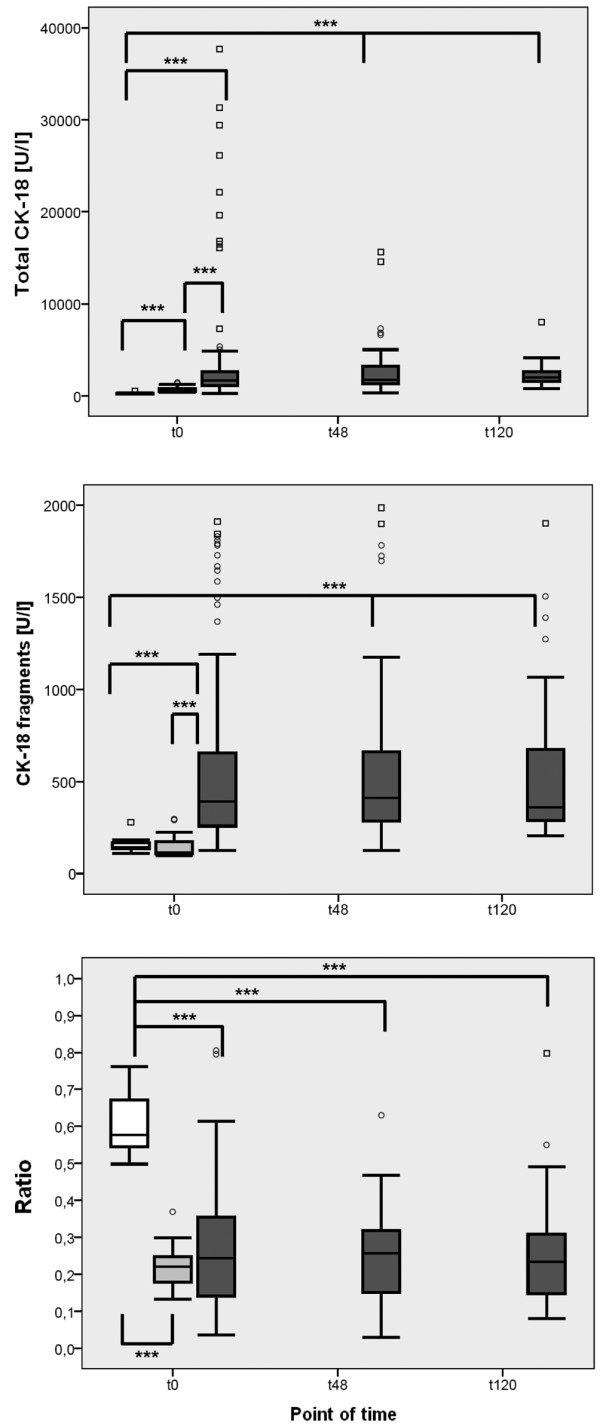
Comparison of cytokeratin measurements in the volunteer, postoperative, and septic groups at baseline and at 48 and 120 hours in the septic group. Concentrations were measured of total cytokeratin-18 (CK-18) and CK-18 fragments (CK-18-F), and the ratio of CK-18-F to total CK-18 was calculated from the sera of healthy volunteers ('Healthy', n = 18, white box), postoperative patients after major abdominal surgery ('Post-op', n = 28, light grey box), and patients with sepsis ('Sepsis', n = 101, dark grey box), at t0 (measured once for the volunteer group, immediately after surgery for the postoperative group, and at the time of diagnosis of sepsis for the sepsis group). In addition, for the septic group, the two other times of data collection are represented, t48 and t120 for 48 and 120 hours, respectively, after the diagnosis of sepsis. Data in box plots are given as median, 25th percentile, 75th percentile, and the 1.5 interquartile range. Outliers are shown in form of circles (1.5 to 3 interquartile ranges above 75th percentile or below 25th percentile) or rectangles (>3 interquartile ranges above 75th percentile or below 25th percentile). *** P < 0.001.